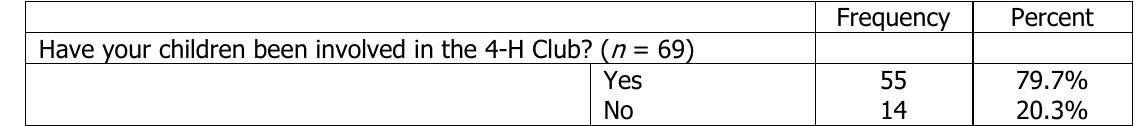
Adult Volunteer’s Children 4-H